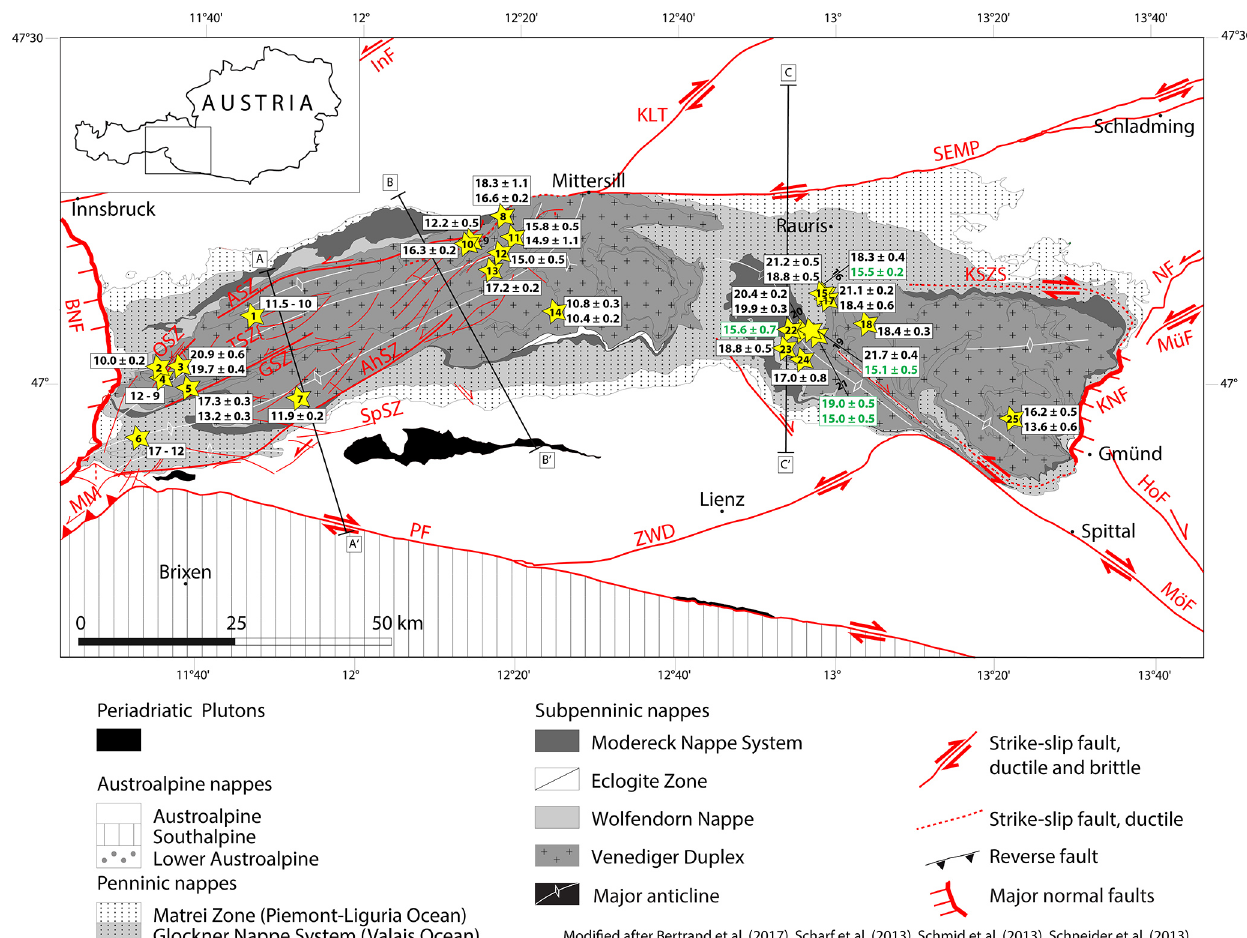
Figure 1. Tectonic map of the TW dome modified after Bertrand et al. (2017), Scharf et al. (2013), Schmid et al. (2013) and Schneider et al. (2013). Yellow stars on the map represent sample locations, and numbers inside the stars refer to samples listed in Table 1. Range of weighted mean growth domain ages are indicated for each grain from this study and Gnos et al. (2015), labelled in black and green, respectively, on the map (see Table 4 for an exhaustive summary of all the ages). Only the spot date range is indicated for grains 1, 4 and 6. Locations of AA’, BB’ and CC’ cross sections are indicated by black lines, and individual cross sections are presented in Fig. 6 together with monazite crystallization ages. Two normal faults delimit the western and eastern borders of the TW, the Brenner normal fault (BNF) and the Katschberg normal fault (KNF), respectively. Note that the KNF prolongation results in dextral and sinistral strike slips in the north and south, respectively (KSZS: Katschberg shear zone system). Several sinistral strike-slip faults (AhSZ: Ahrntal shear zone; ASZ: Ahorn shear zone; DAV: Defereggen–Antholz–Vals fault; GSZ: Greiner shear zone; InF: Inntal fault; MüF: Mur–Mürz fault; NF: Niedere